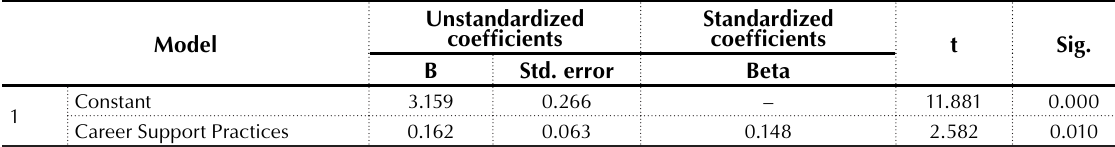
Table 6. Impact of career support practices on acclimatization of